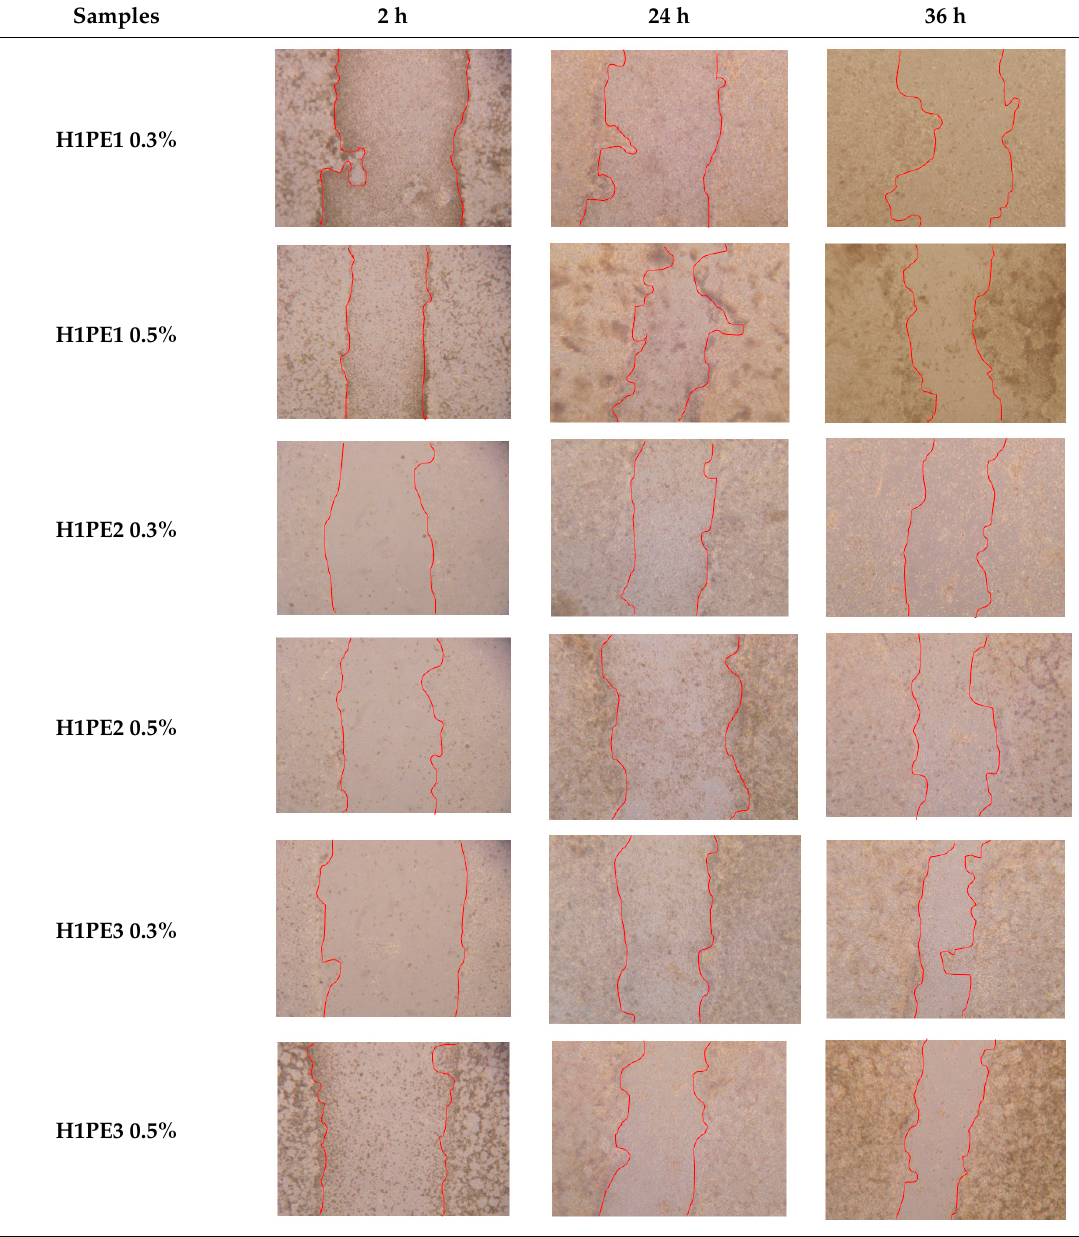
Table 5. Microscopic images obtained from the scratch wound-healing assay with the mixtures of honey with propolis (magnification: 100×).